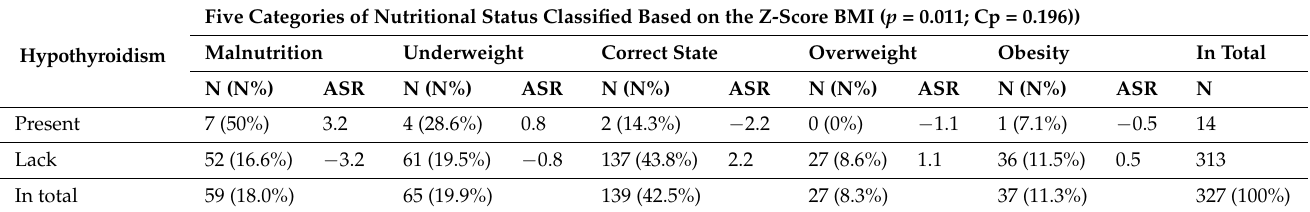
Table 15. Relationship between five categories of nutritional status and accompanying recognition hypothyroidism. Five Categories of Nutritional Status Classified Based on the Z-Score BMI ( p = 0.011; Cp = 0.196)) Hypothyroidism